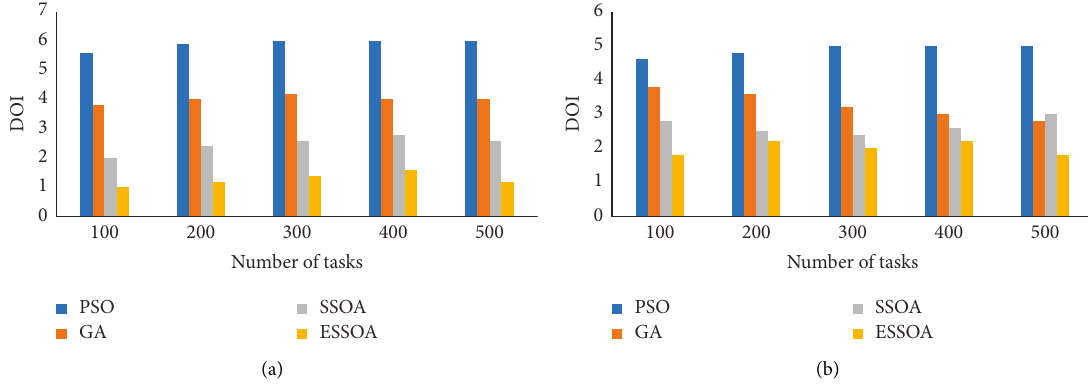
Figure 5: DOI of the proposed and existing techniques. (a) DOI using Google Cluster and (b) DOI using